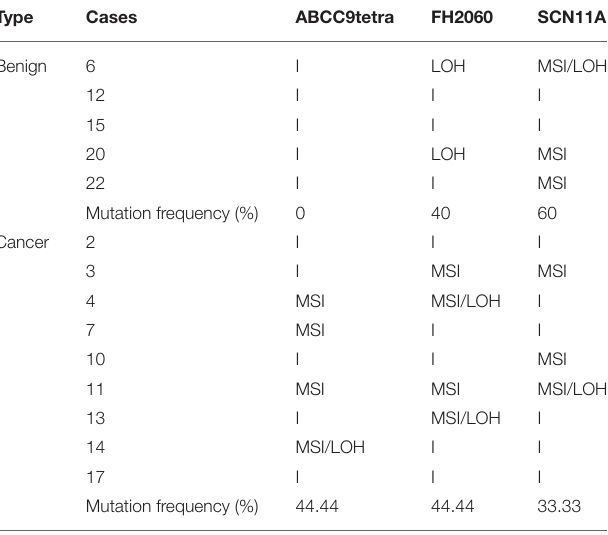
TABLE 3 | Classification of mutated microsatellite DNA markers. Motif